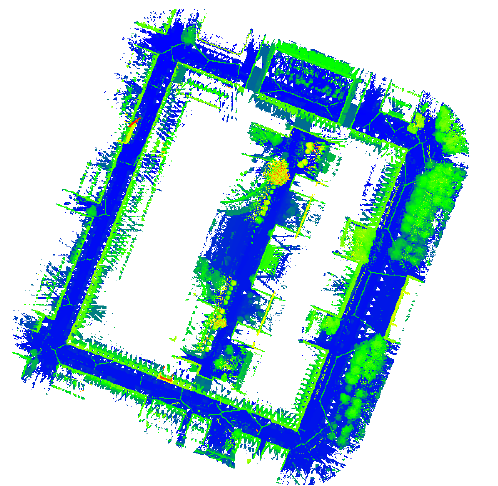
Figure 5. Nadir view over the complete point cloud dataset: raw data colored by height